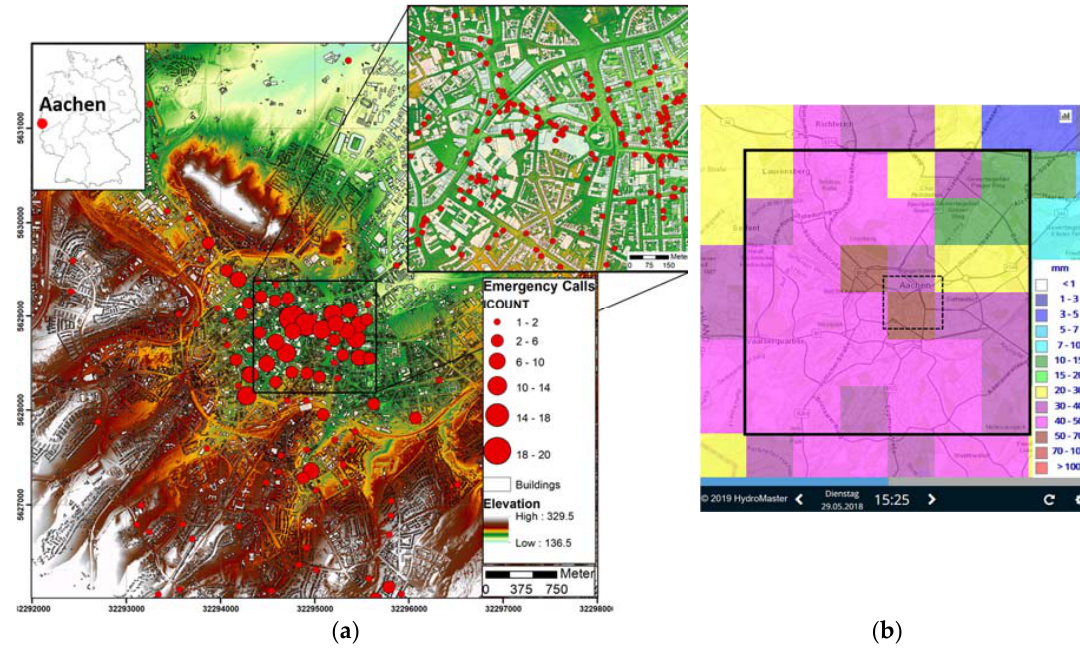
Figure 4 : ( a ) Digital elevation model (DEM) of the study area including positions of emergency calls of the pluvial event in 29 May 2018 in the city of Aachen with enlarged view of central areas (Kaiserplatz) and ( b ) measured 1 h rainfall pattern (14:25–15:25 h) of the May event [36] highlighting the complete case study area (black rectangle) and special focus area (dashed